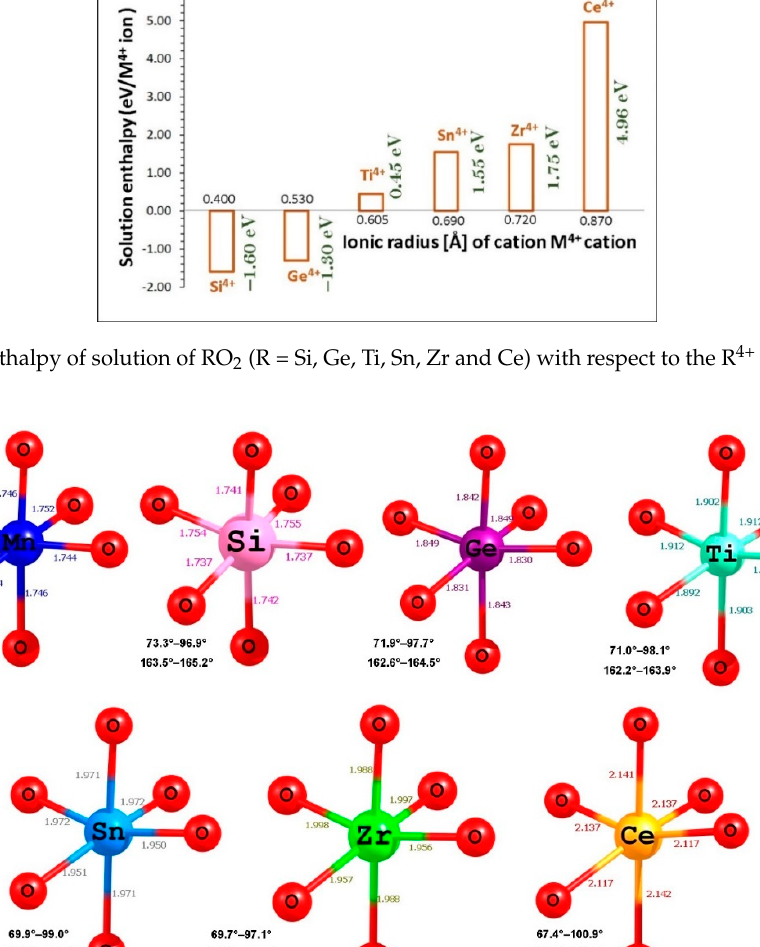
coordination formed by the isovalent (tetravalent) dopants on the Mn site with neighbour oxygen.